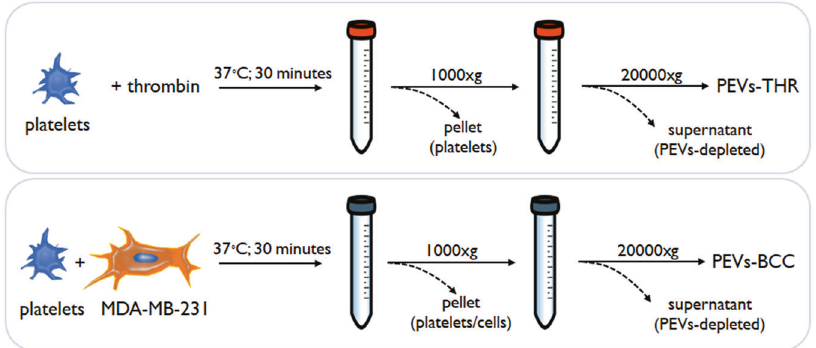
Fig. 1 Graphical summary of the PEVs isolation procedure. Each sample of PEVs was obtained by the stimulation of platelets (5 ml at the concentration of 3 × 10 8 /ml) with 0.1 U/ml thrombin or MDA-MB-231 cells (5 × 10 4